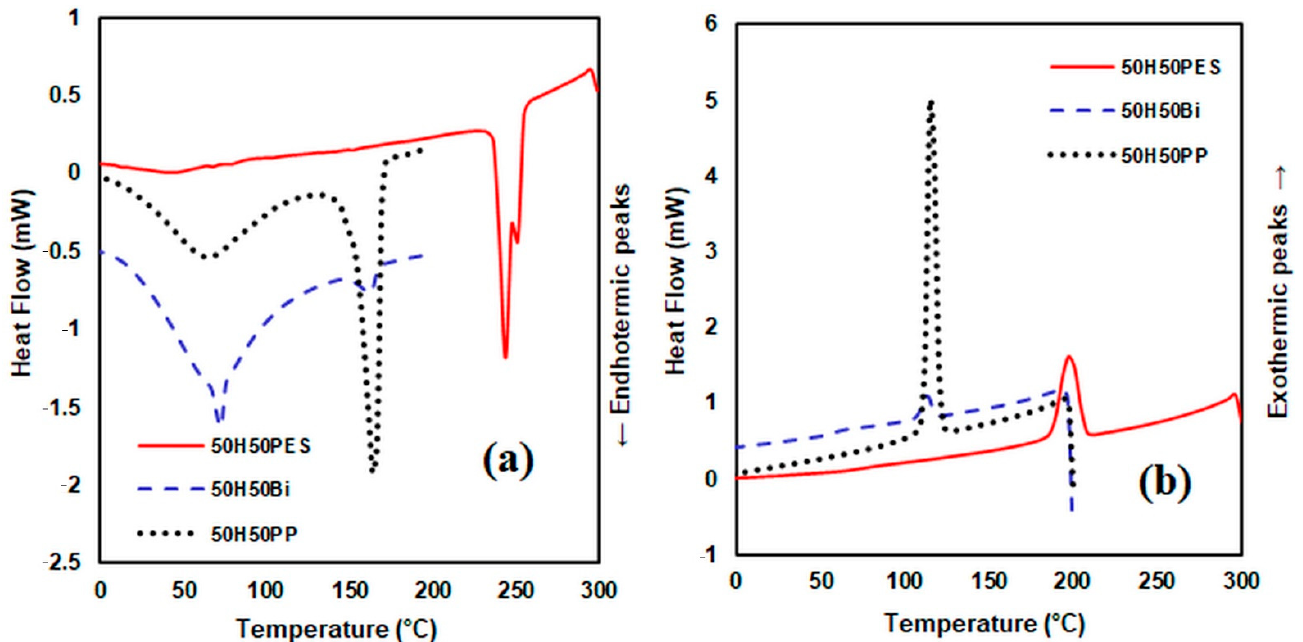
Figure 8. DSC curves heating process ( a ) and DSC curves cooling process ( b ) for composite materials consisting of hemp fibres and various matrices.